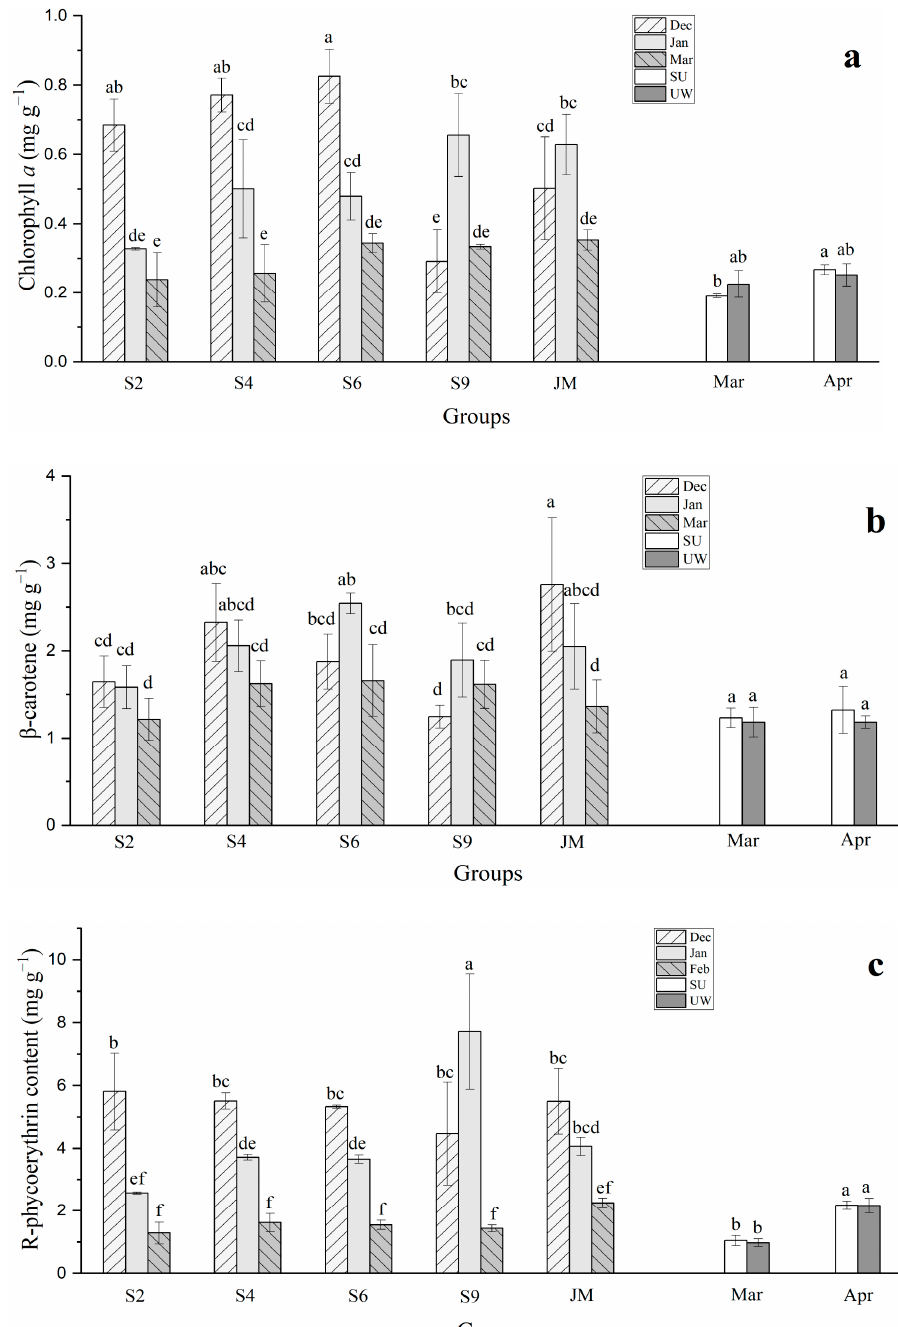
Figure 3. Changes in photosynthetic pigment content of N. yezoensis under different conditions. ( a ) chlorophyll a ; ( b ) β -carotene; ( c ) R-phycoerythrin. Data represent the mean ± SD ( n = 3). Different letters indicate a significant difference ( p <